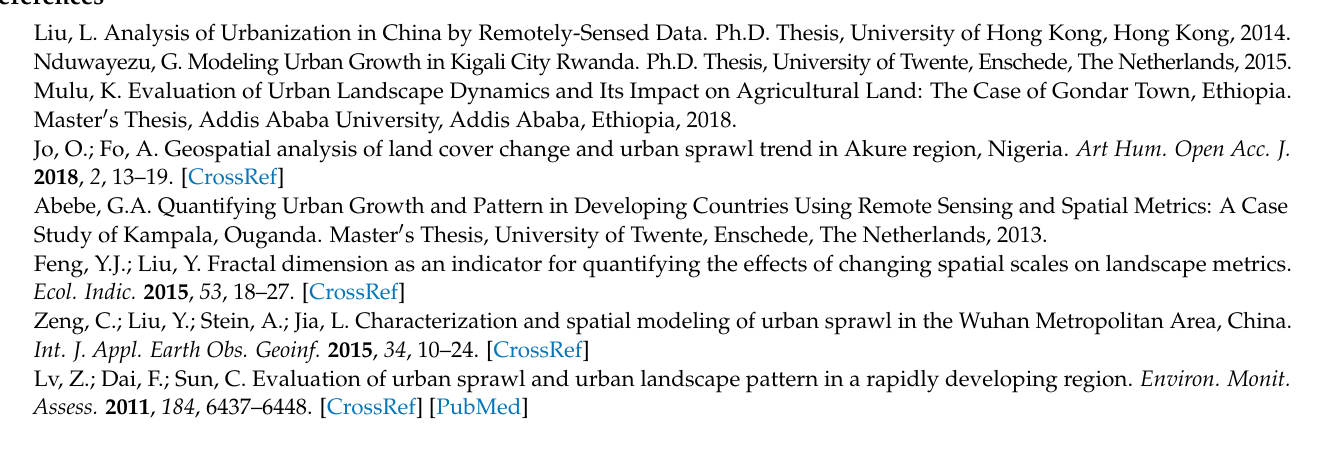
Figure S2: Land use/cover maps for Commune 2: a (1990); b (2000); c (2010); d (2018), Figure S3: Land use/cover maps for Commune 3: a (1990); b (2000); c (2010); d (2018), Figure S4: Land use/cover maps for Commune 4: a (1990); b (2000); c (2010); d (2018), Figure S5: Land use/cover maps for Commune 5: a (1990); b (2000); c (2010); d (2018), Figure S6: Land use/cover maps for